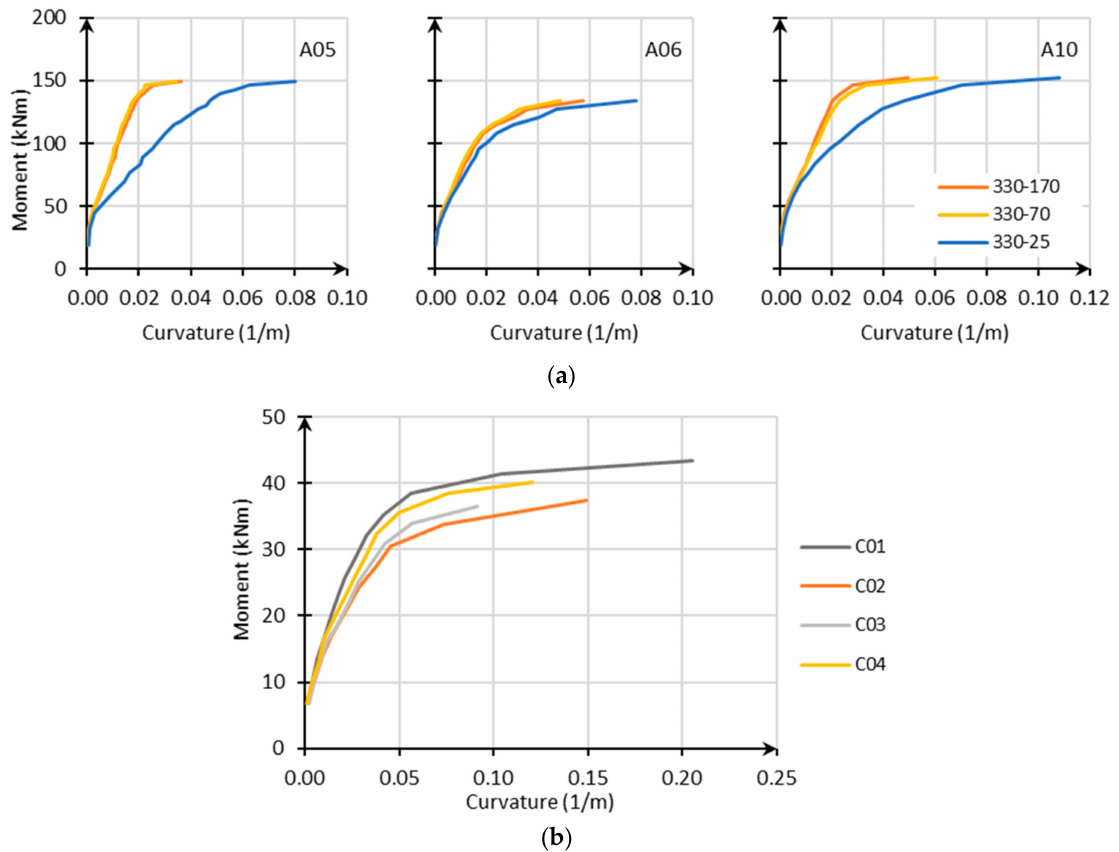
Figure 9. Moment–curvature relationship for ( a ) A-series (A05, A06, and A10); ( b ) C-series (C01 to C04). A curvature ductility factor µ Φ is used mostly as a reference in the assessment of local ductility condition. Here, µ Φ is defined as the ratio of post-yield strength curvature